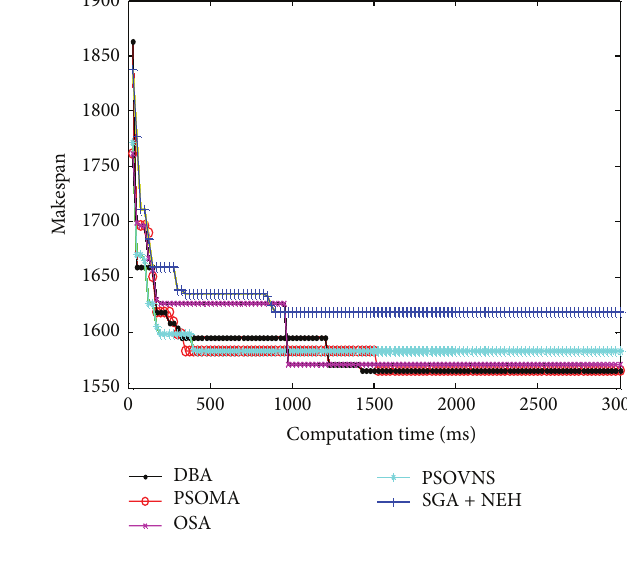
Figure 12: The convergence curves of Rec7.